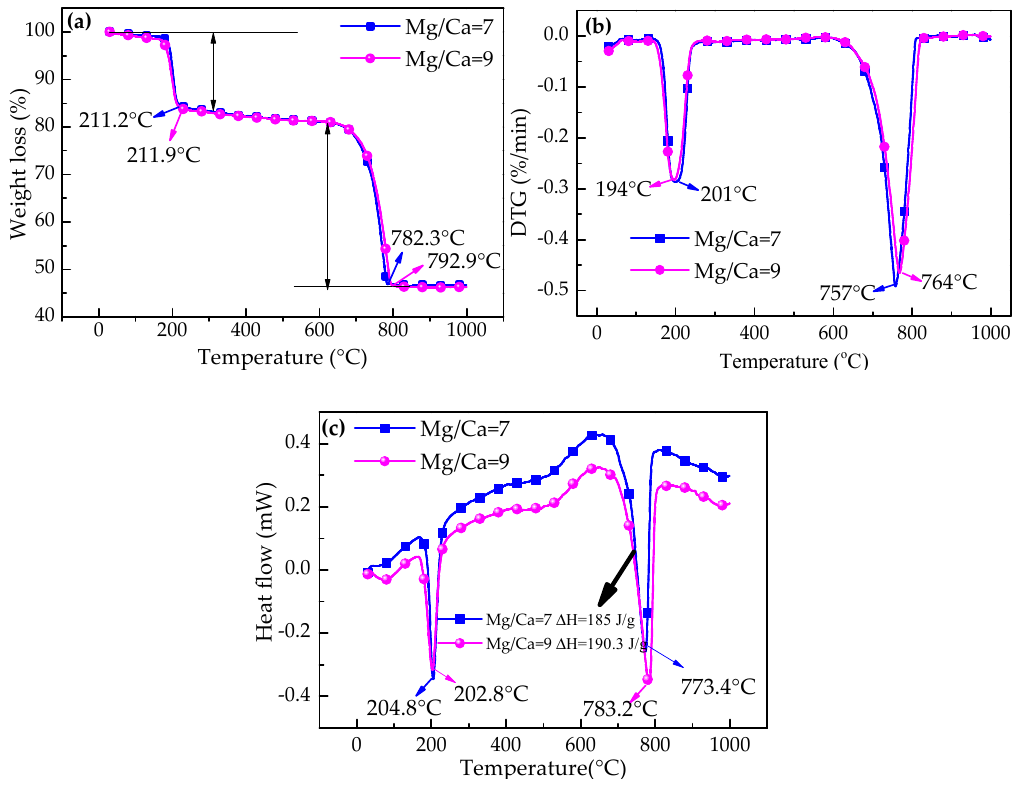
Figure 8. Thermogravimetry (TG) ( a ), differential thermogravimetry (DTG) ( b ), and differential scanning calorimetry (DSC) ( c ) analyses of minerals induced by H. smyrnensis WMS-3 bacteria cultured for 30 days at a heating rate of 10 °C min − 1 .